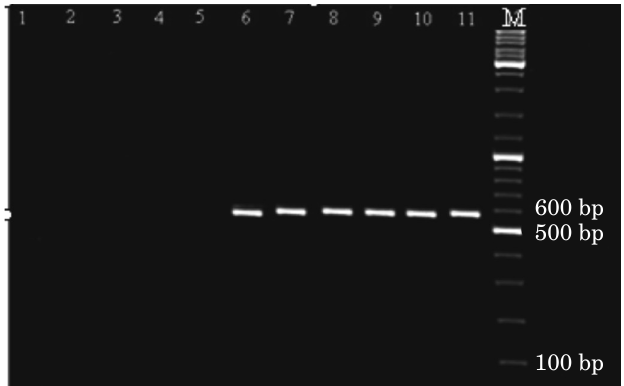
Figure 1. Agarose gel electrophoresis of PCR-products from Pcc strains with primers EXPCCR and EXPCCRF. Lanes: M, DNA molecular marker; 1, S7; 2, S8; 3, Po7; 4, Po11; 5, O4; 6, Ecc SCRI 193; 7, S1; 8, S3; 9, Po1; 10, L2; 11, Cb2.